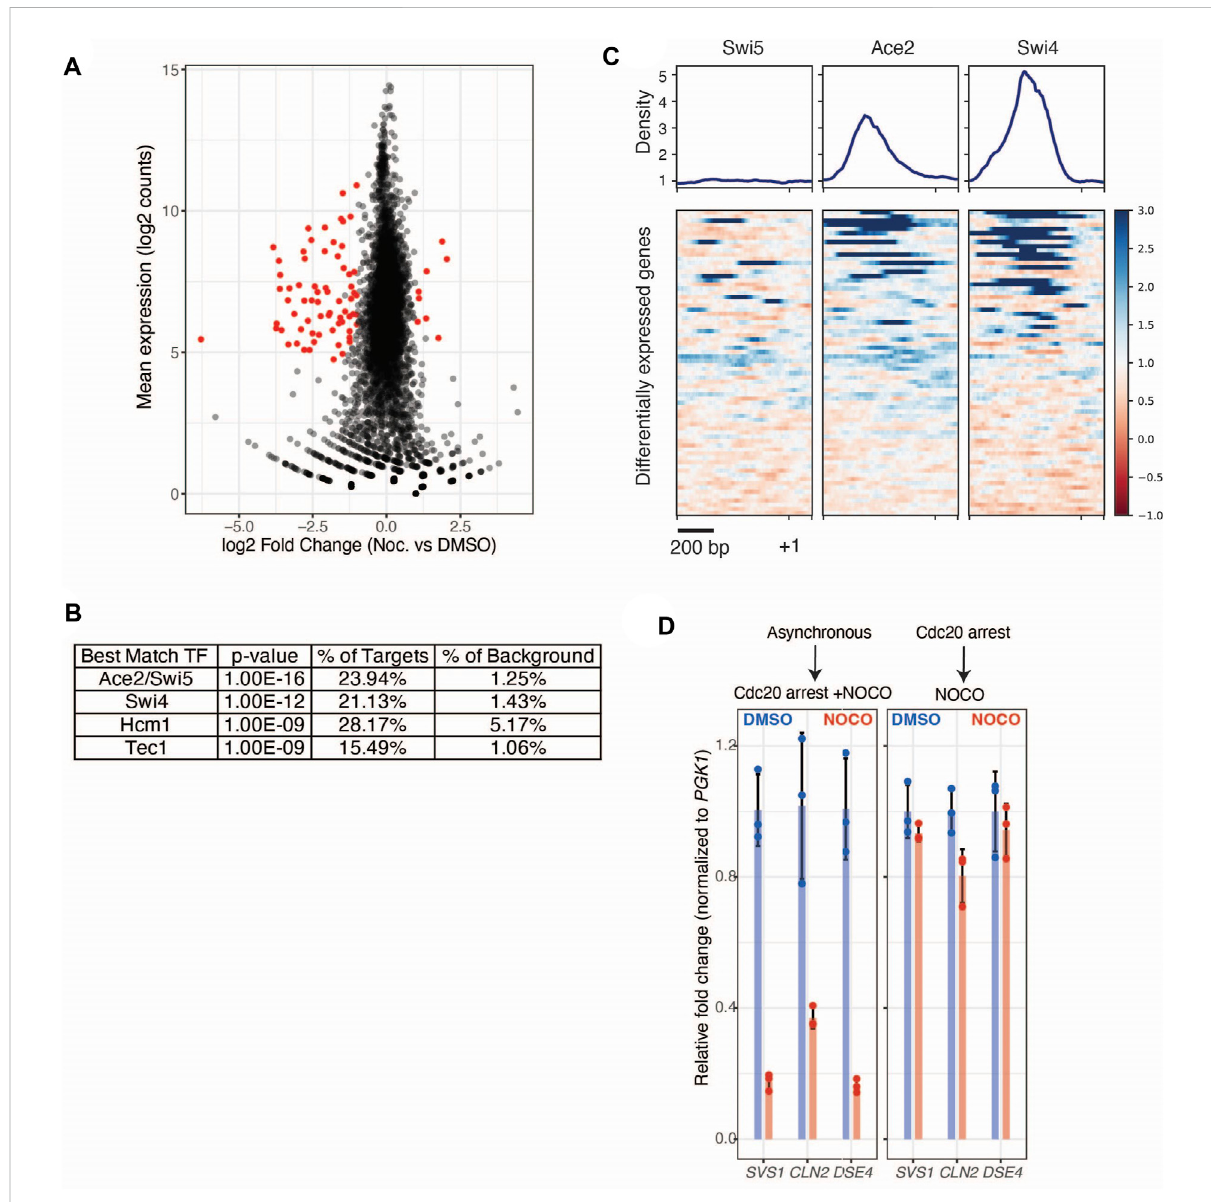
FIGURE 2 Nocodazole treatment induces transcriptional regulation of Ace2 target genes. (A) mRNA-seq data from cdc20-AID (SBY14004) cells treated with DMSO or nocodazole. Altered expression of genes upon nocodazole treatment. Log2 mean counts across all replicates and conditions plotted on the y-axis, with log2 fold change (nocodazole vs. DMSO) plotted on the y-axis. Individual genes are represented as black dots, and differentially expressed genes (Wald test, Benjamini Hochberg adjusted p < 0.05 and fold-change > 2) are colored in red. (B) Motif discovery analysis (HOMER) identi fi cation of the top 5 signi fi cant transcription factor motifs enriched within promoters of differentially expressed genes. (C) Binding pro fi le and heatmap of Swi5, Ace2, and Swi4 ChIP-seq (Rossi et al., 2021) across the promoters of differentially expressed genes from (A) . Each row represents a 1.2 kb window ( − 1 kb to +0.2 kb) around a given gene ’ s start codon and heatmap is sorted by maximum ChIP signal for each promoter. (D) Nocodazole induced decrease in gene expression in CDC20-AID cells (SBY14004) treated with auxin and either nocodazole (10 μ g/ml; Red) or DMSO (Blue). Cells were simultaneously treated with auxin and drug (left) or were sequentially treated (right). N = 3 independent replicates for each treatment. qRT-PCR quanti fi cation of individual gene expression values ( SVS1, CLN2, DSE4 ) were normalized to PGK1 expression values within the same sample and fold change is relative to DMSO controls. Error bars represent standard